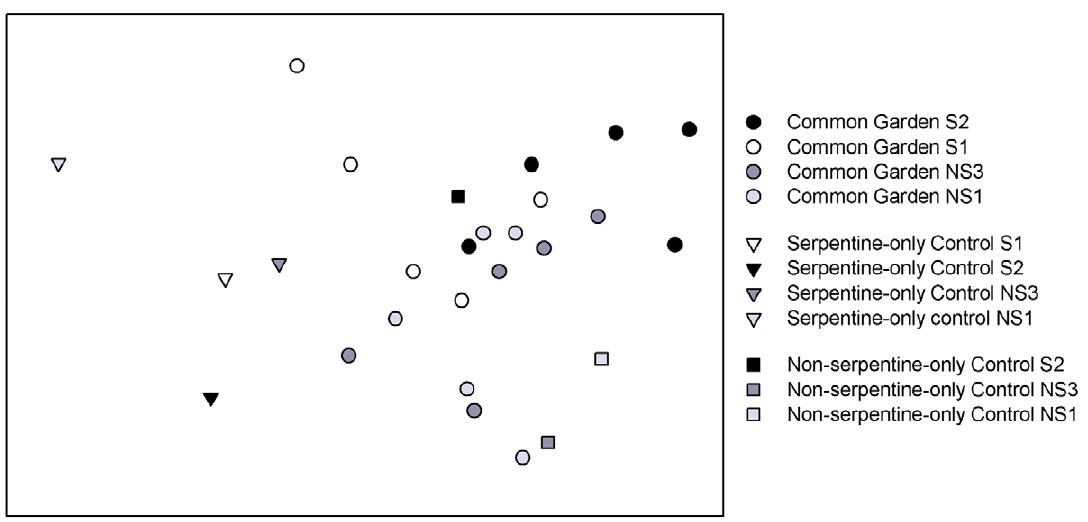
Figure 1. Non-metric multi-dimensional scaling ordination of AMF assemblages associated with ecotype populations (S1, S2, NS1, and NS3) of Collinsiasparsiflora grown in a common garden of serpentine and non-serpentine AMF (each point represents AMF assemblage from a pooled sample of two seedling replicates), serpentine soil control or non-serpentine soil control AMF (each data point represents AMF assemblage from a pooled sample of four seedling replicates). The non-metric multi-dimensional scaling ordination is a configuration of the samples in which relative positions are assigned based on the Bray–Curtis similarity matrix of the data so that samples closer together have a higher similarity of component taxa than samples farther apart and overlapping samples are highly similar. The nonmetric scale of the ordination does not assign values to the axes. Note: S1 plants growing in non-serpentine-only control grew poorly and resulted in insufficient root tissue mass for downstream molecular identification of AMF associates.